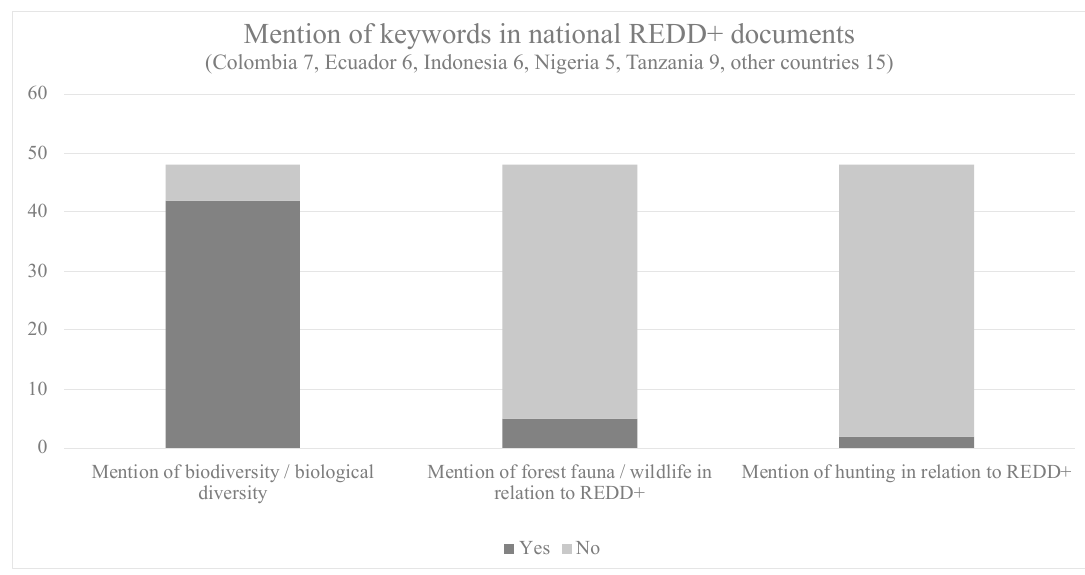
Figure 2. Mention of keywords in national program documents, national communication to the UNFCCC reports, and other published REDD+ documents for the five countries and the national REDD+ strategies and national program documents for 15 other tropical forest REDD+ countries (see Table S1, Supplementary Materials for the complete list of countries and documents included).